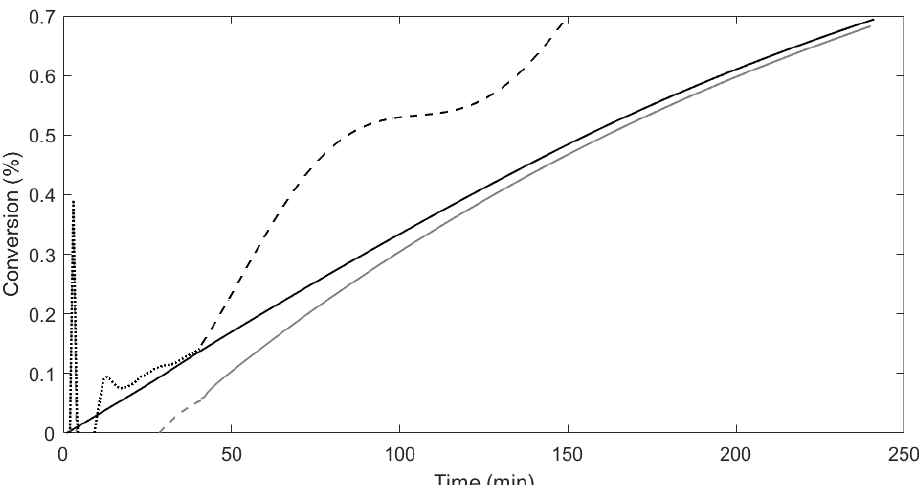
Figure 1. The conversion predictions from both models with every tenth quality measurement retained and 30% missing output data. The dashed grey lines represent Luenberger observer estimates until the 40th minute and the solid grey line shows the predictions from the proposed approach in comparison to the process, represented by the solid black line. The dotted and dashed black lines show the predictions made by the Luenberger observer and traditional subspace identification using linear interpolation, respectively.